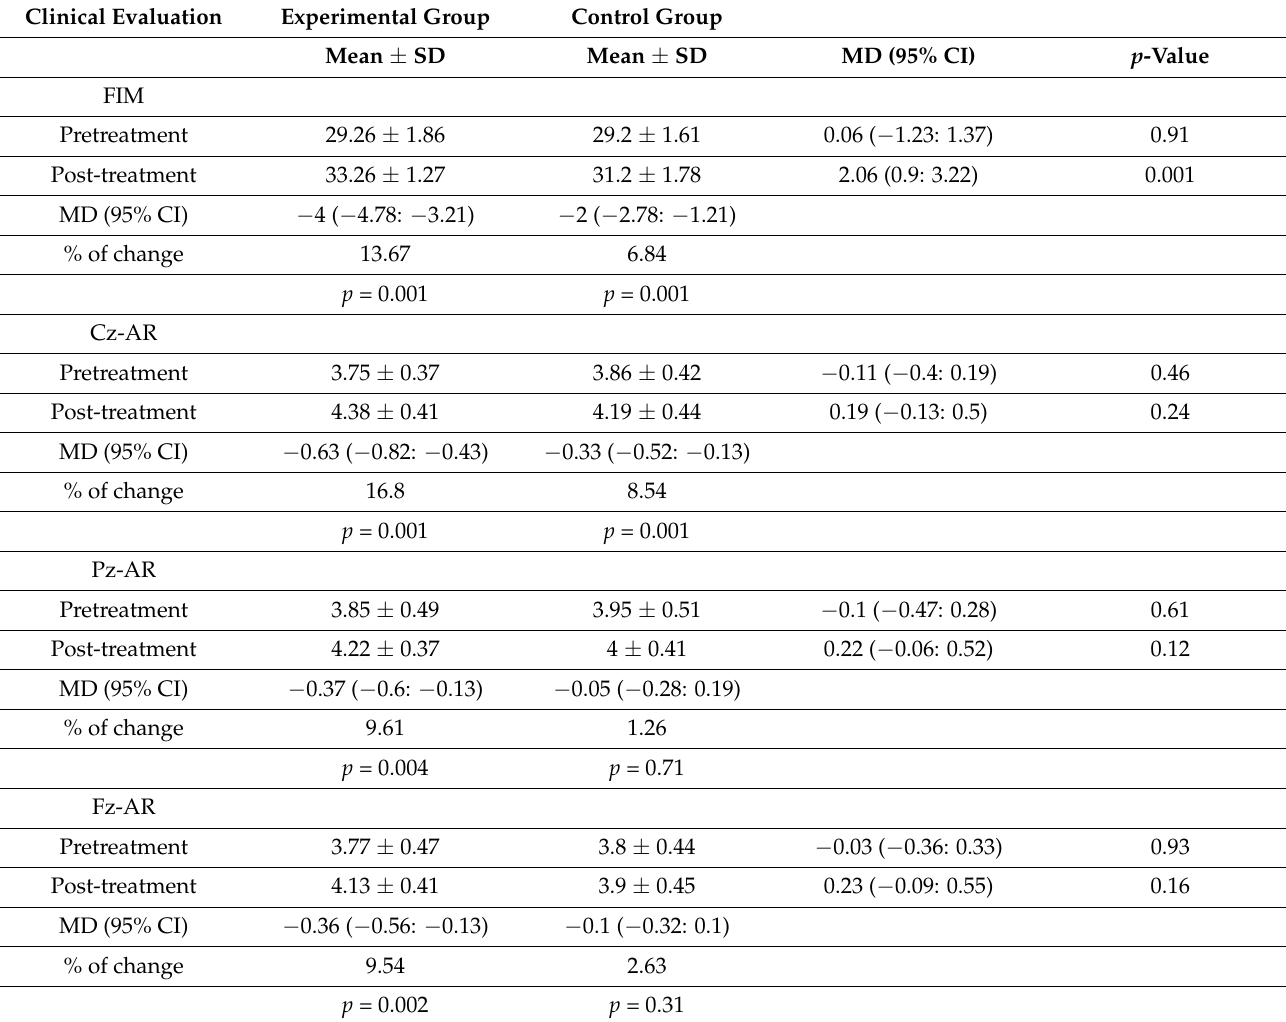
Table 2. Functional Independence Measure (FIM), Cz-AR, Pz-AR and Fz-AR scores before and after treatment in GI and GII. Clinical